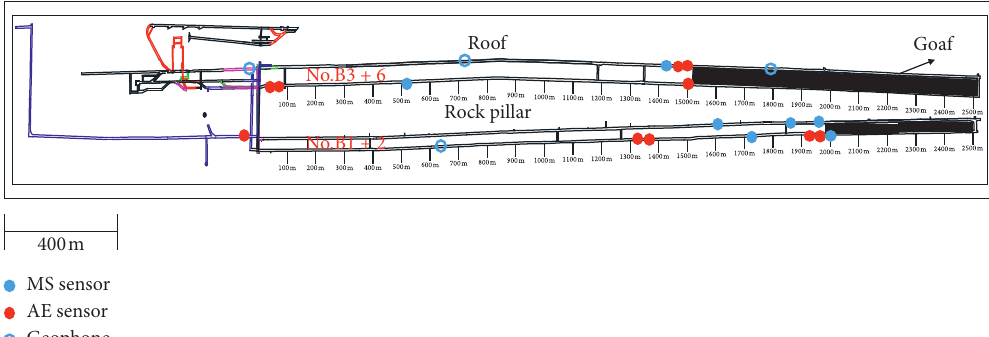
Figure 4: Network layout of MS and AE monitoring system in No. B 3 +6 coal seam +450 horizontal working face of WCM during the research